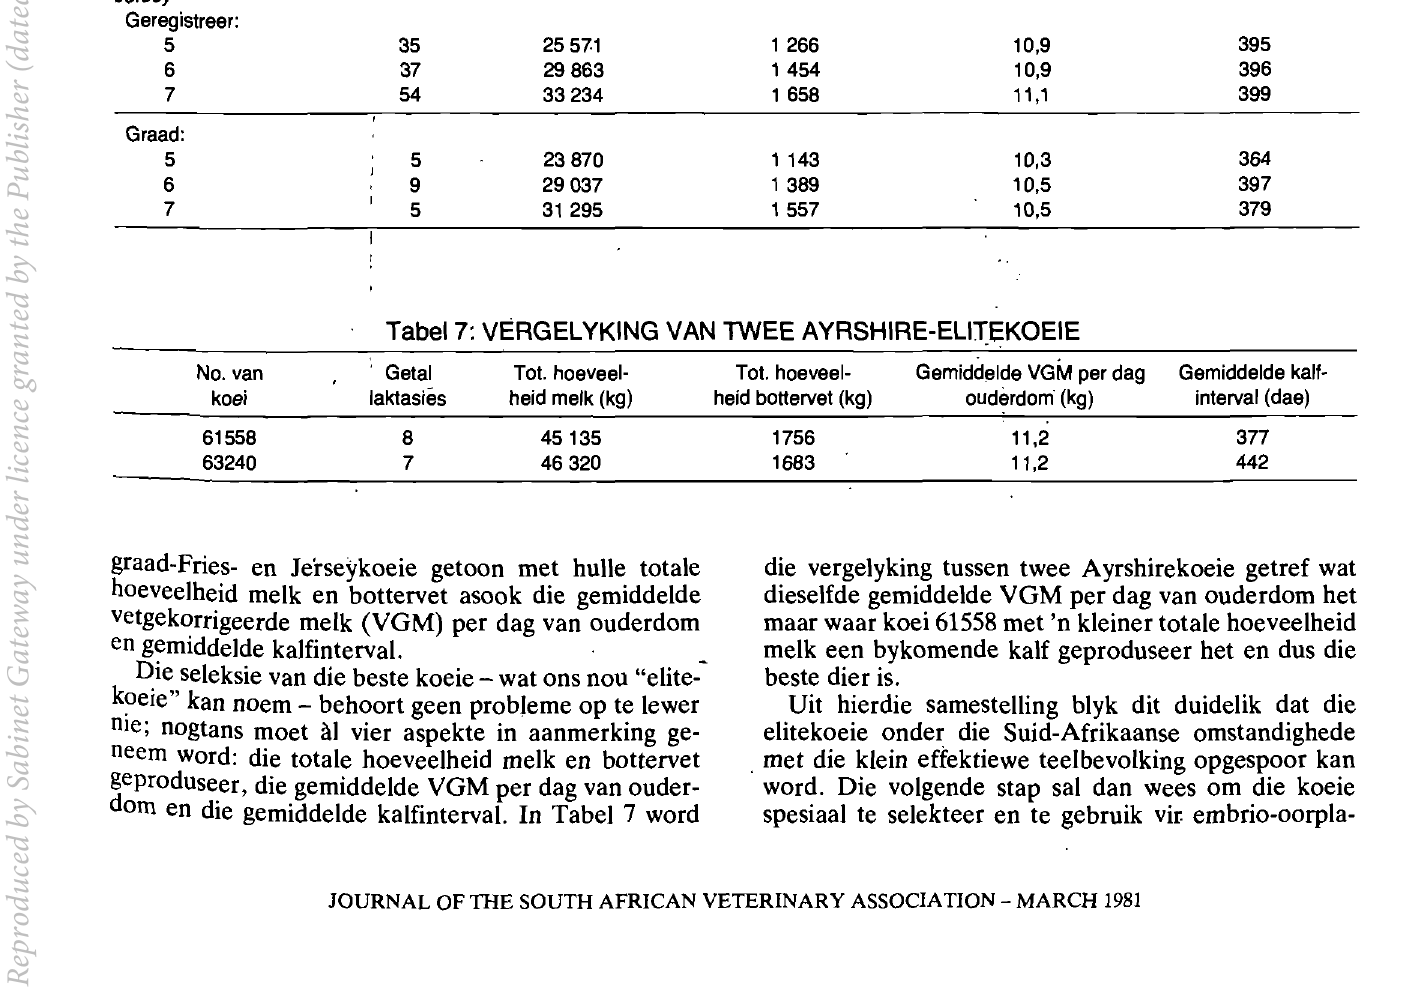
Tabel7: VERGELYKING VAN TWEE AYRSHIRE-ELrt:EKOEIE